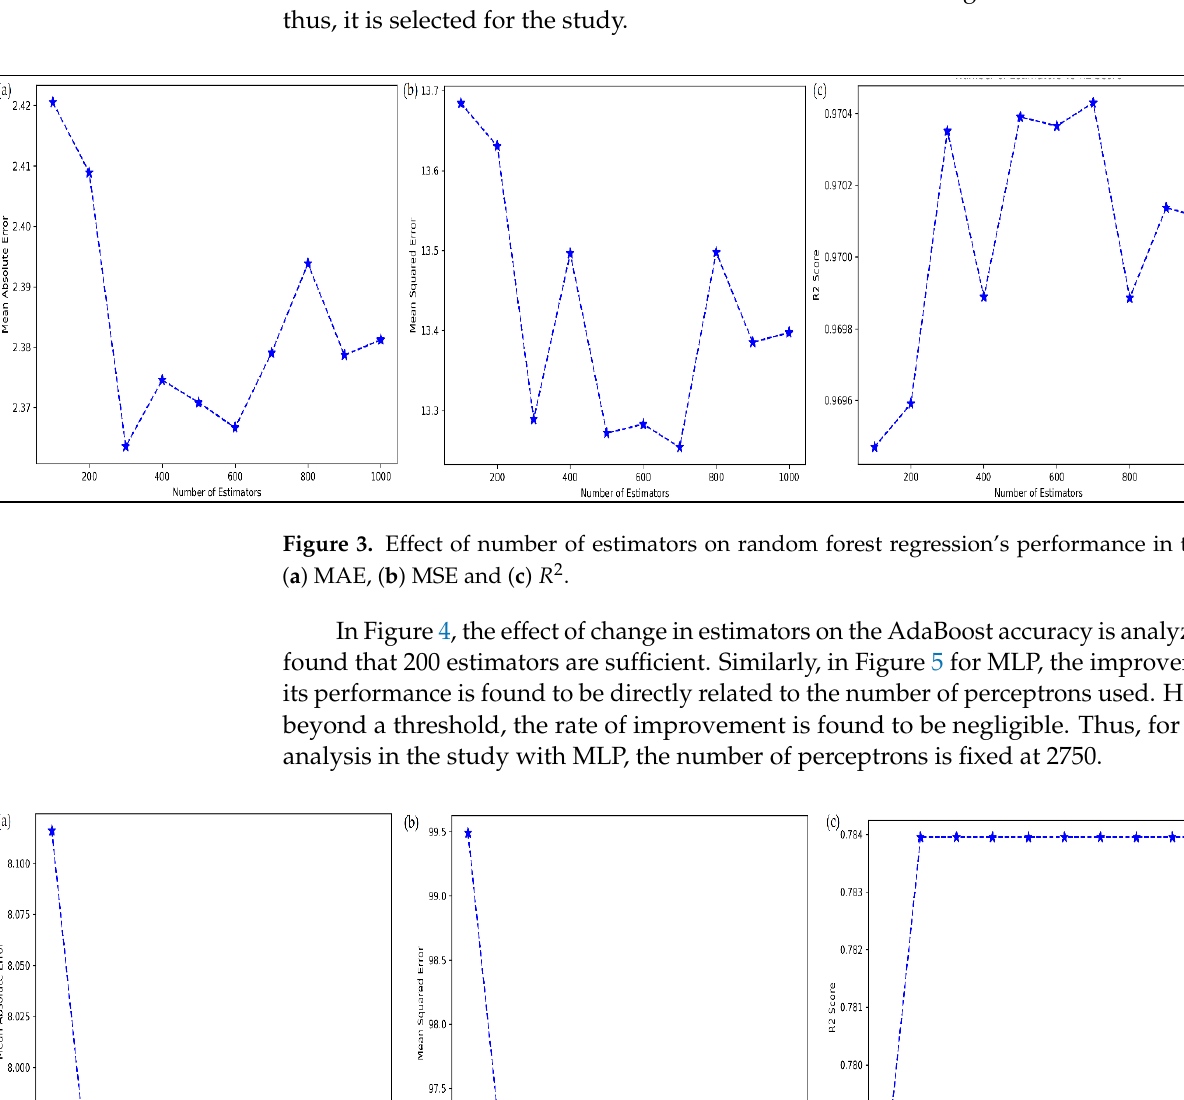
Figure 4. Effect of number of estimators on AdaBoost regression’s performance in terms of ( a ) MAE, . ( b ) MSE and ( c ) 2 𝑅𝑅